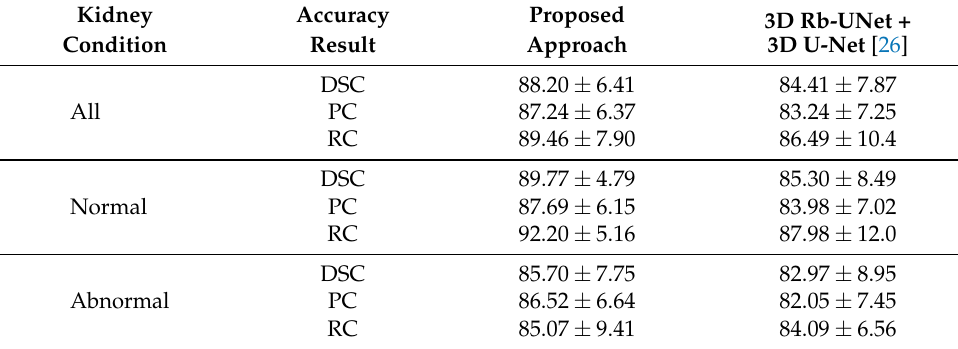
Table 1. Comparison of the whole kidney segmentation